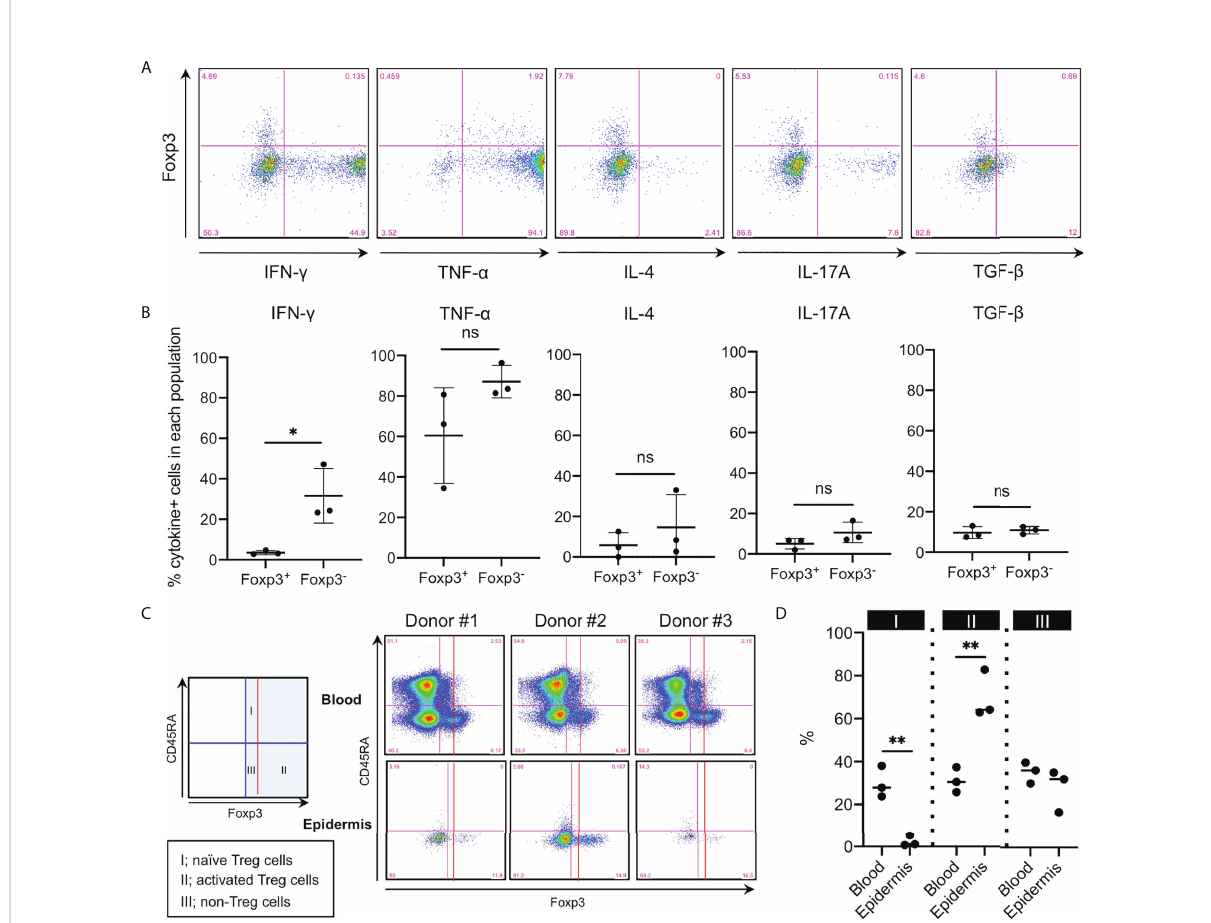
FIGURE 6 Less in fl ammatory cytokine production and activated phenotype of the epidermal Foxp3 + CD4 + T cells. (A) Representative cytokine expression in the epidermal CD3 + CD4 + cells. Cells were incubated with eBioscience Cell Stimulation Cocktail (500x) and eBioscience Protein Transport Inhibitor Cocktail (500x) for 6 h at 37°C. (B) A summary of cytokine-positive cells in the epidermal Foxp3 + and Foxp3 − CD3 + CD4 + cells. (C) CD45RA and Foxp3 expression in CD3 + CD4 + cells of PBMCs and the epidermis. (D) A summary of the three populations ’ percentage in (C) . All the experiments were conducted using at least three different samples. Comparisons between groups were evaluated using Student ’ s t - test (one-tailed); * p < 0.05 and ** p < 0.01. ns, not signi fi